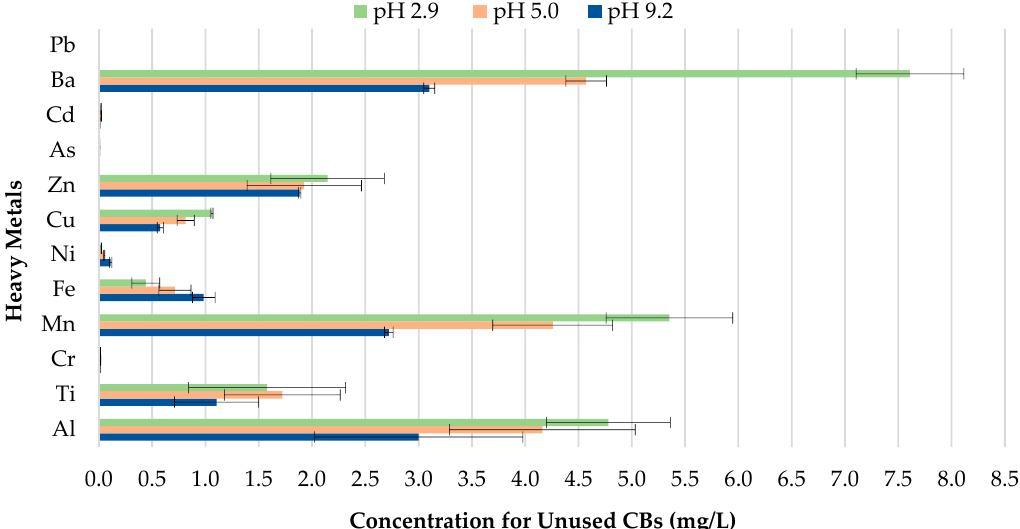
Figure 7. Leachate concentrations of unused CBs.